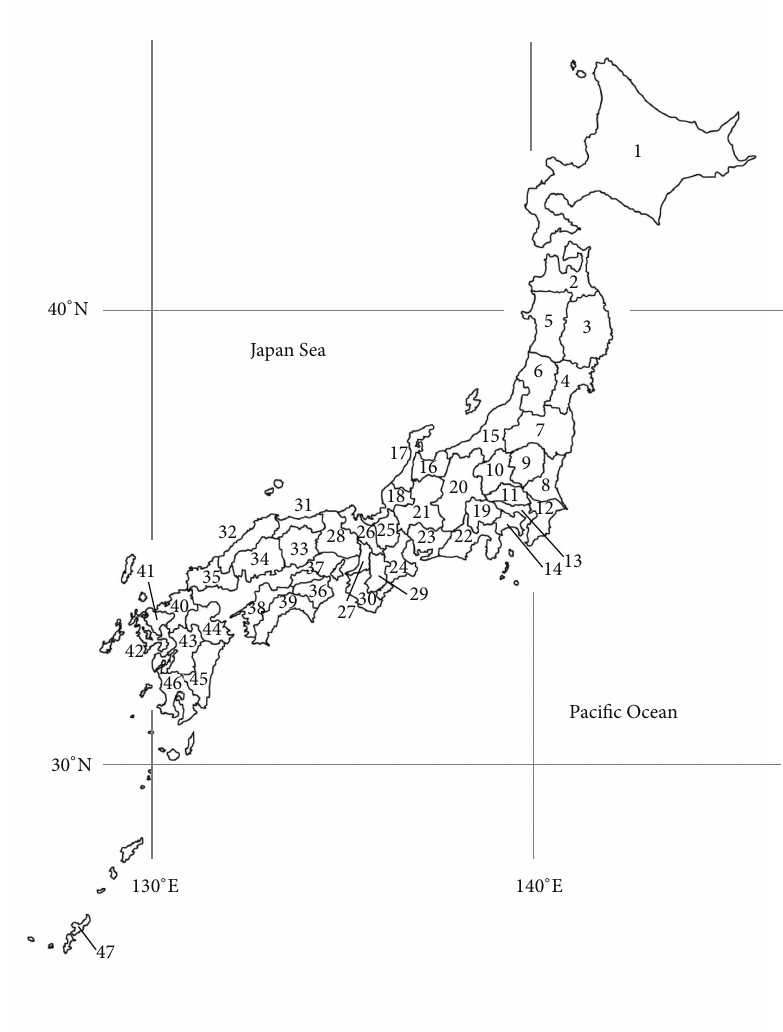
Figure 1: Map of the 47 prefectures of Japan. Numbers correspond to the prefecture information presented in Tables S1–S4 [19].